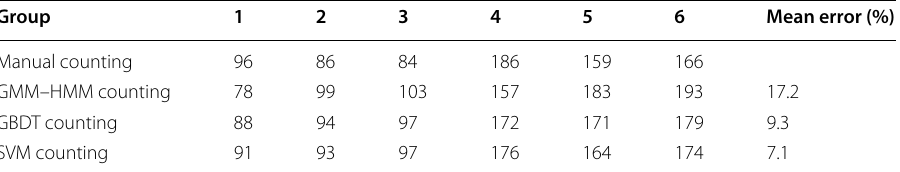
Table 4 Dynamic monitoring